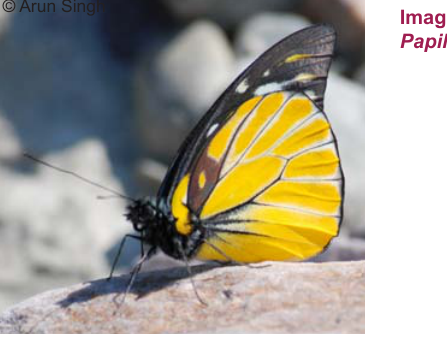
Image 17. Great Mormon Papilio memnon